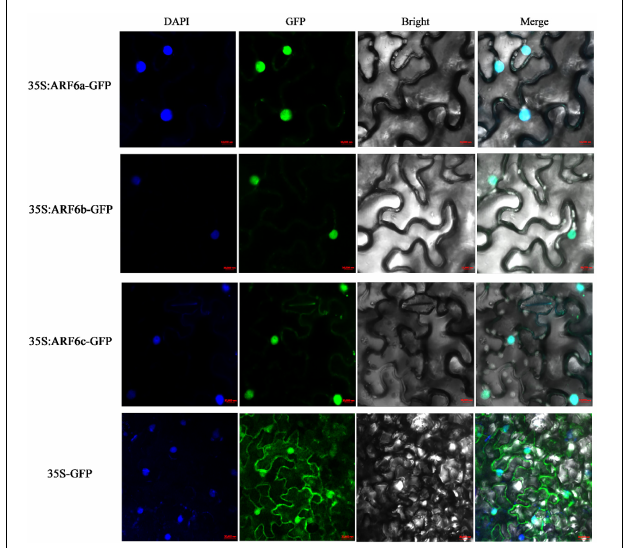
FIGURE 4 | Subcellular localization of PgARF6s-GFP fusion in tobacco.